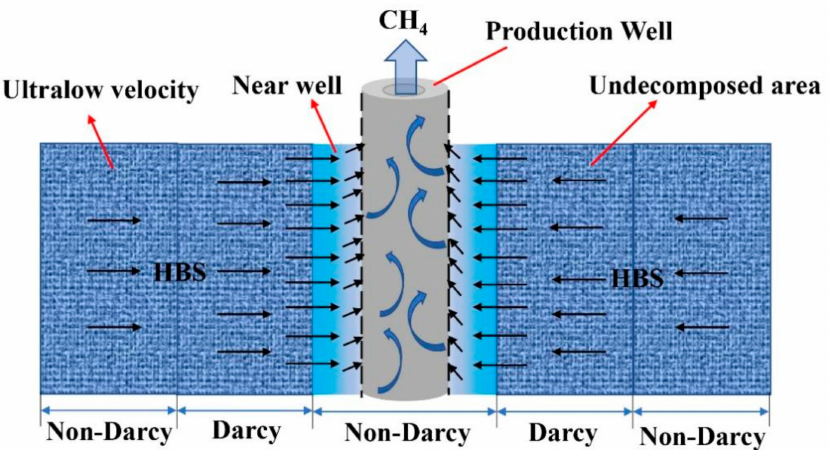
Figure 1. The distribution of flow characteristics in hydrate